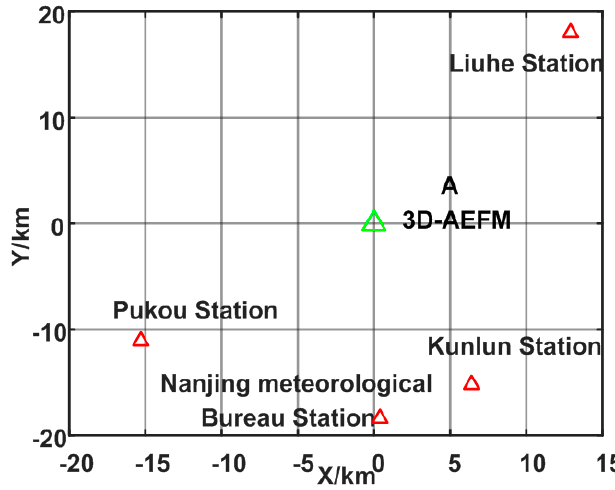
Figure 7. Monitoring network of the atmospheric electric field meter in Nanjing.